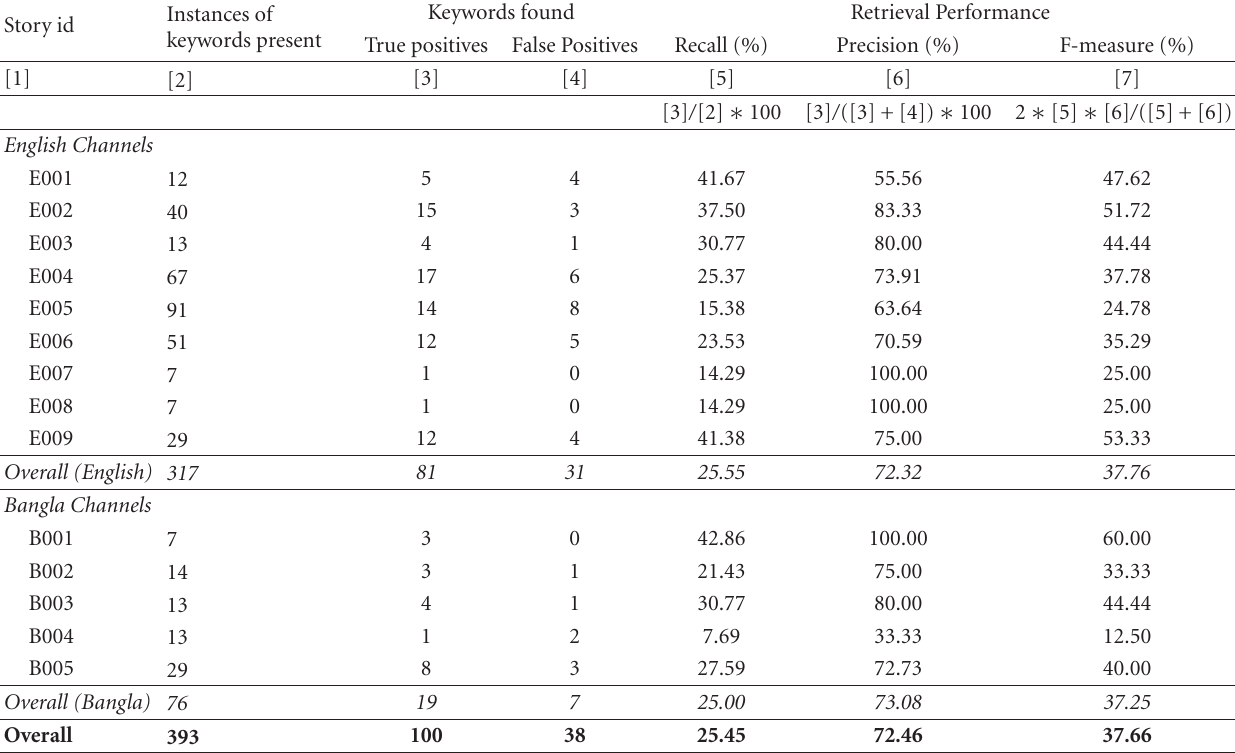
Table 2: Results for keyword spotting in speech with constrained keyword